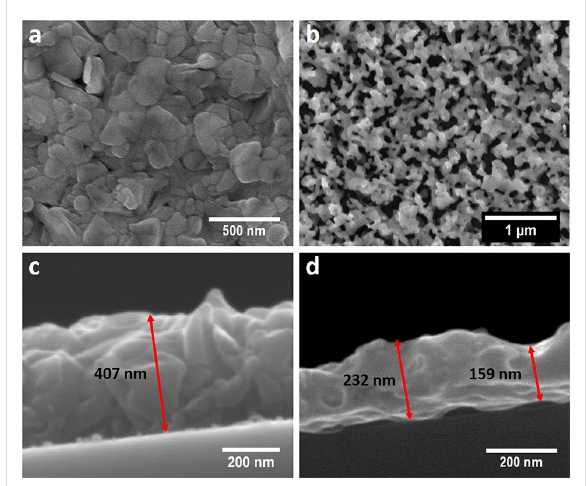
(a) oxygen plasma (g12-p200) for 15 min and (b) after reducing the oxidized silver film with hydrogen plasma (g12-p200) for 20 min. Cross-sectional SEM image of 200 nm sputtered silver film treated with (c) oxygen plasma (g12-p200) for 15 min and (d) after reducing the oxidized silver film with hydrogen plasma (g12-p200) for 20 min showing the actual thickness of the prepared silver film after plasma